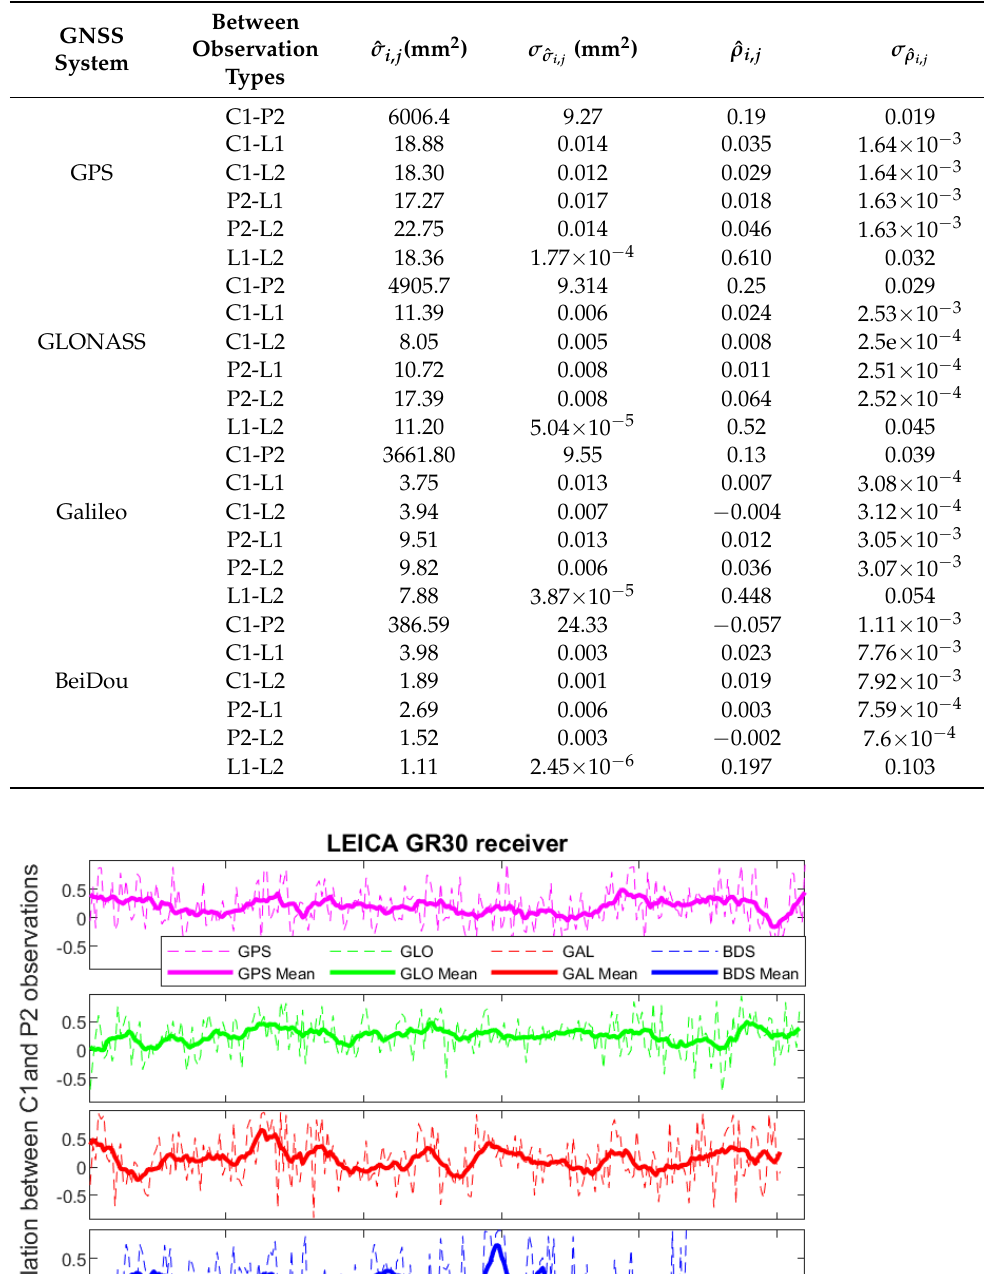
Table 7. Covariances and correlation coefficient and their precision between the observation types for each system for LEICA GR30 receiver over a very short baseline.